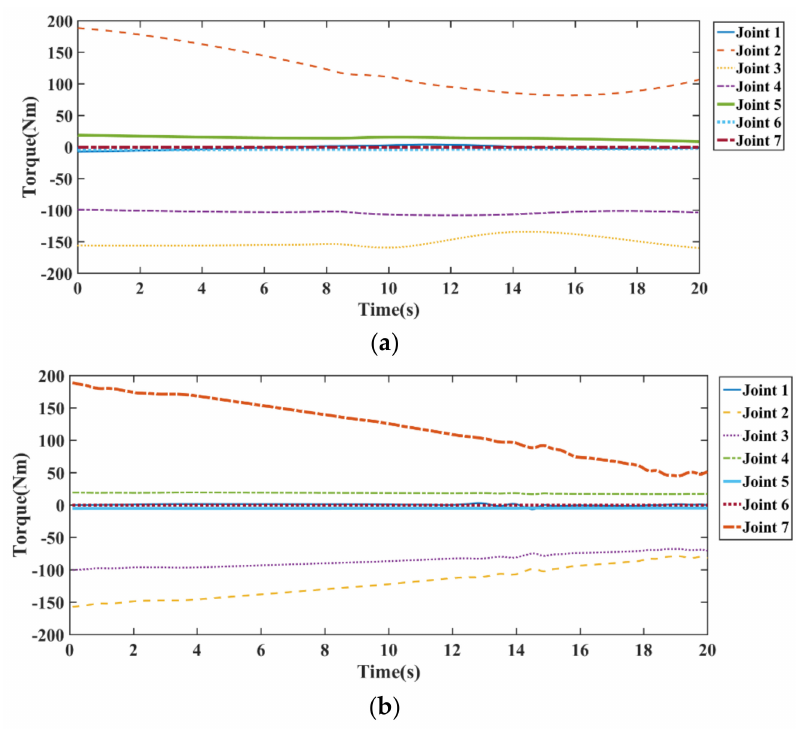
Figure 13. Joint torque of trajectories. ( a ) Without optimization, ( b ) With optimization.